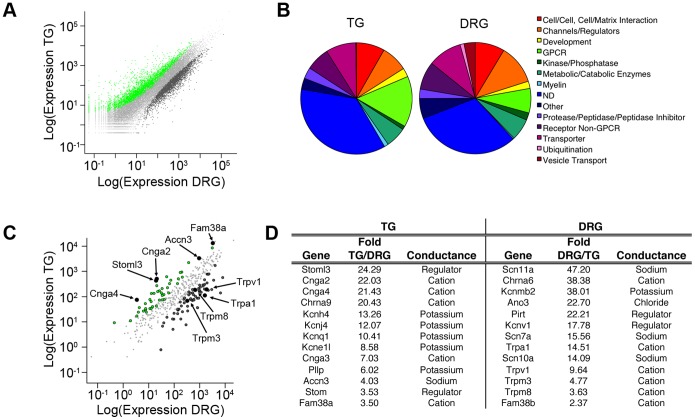
Transcriptome profiling of mole trigeminal and dorsal root ganglia.(A) Dot plot of expression levels of mapped genes in the star-nosed mole TG and DRG. Genes differentially expressed between TG or DRG (padj< = 0.05) are shown in green and dark grey, respectively. (B) Gene Ontology classification of transmembrane proteins differentially expressed between the star-nosed mole TG and DRG. (C) Dot plot of expression levels of known ion channels in the star-nosed mole TG versus DRG. Genes differentially expressed between TG or DRG (padj< = 0.05) are shown in green and dark grey, respectively. Black dots represent individual genes as labeled. (D) Top channels and channel regulators enriched in mole TG and DRG. This list excludes channels also differentially expressed between mouse ganglia. Table shows gene name in mouse, fold enrichment in mole, and putative ion conductance.